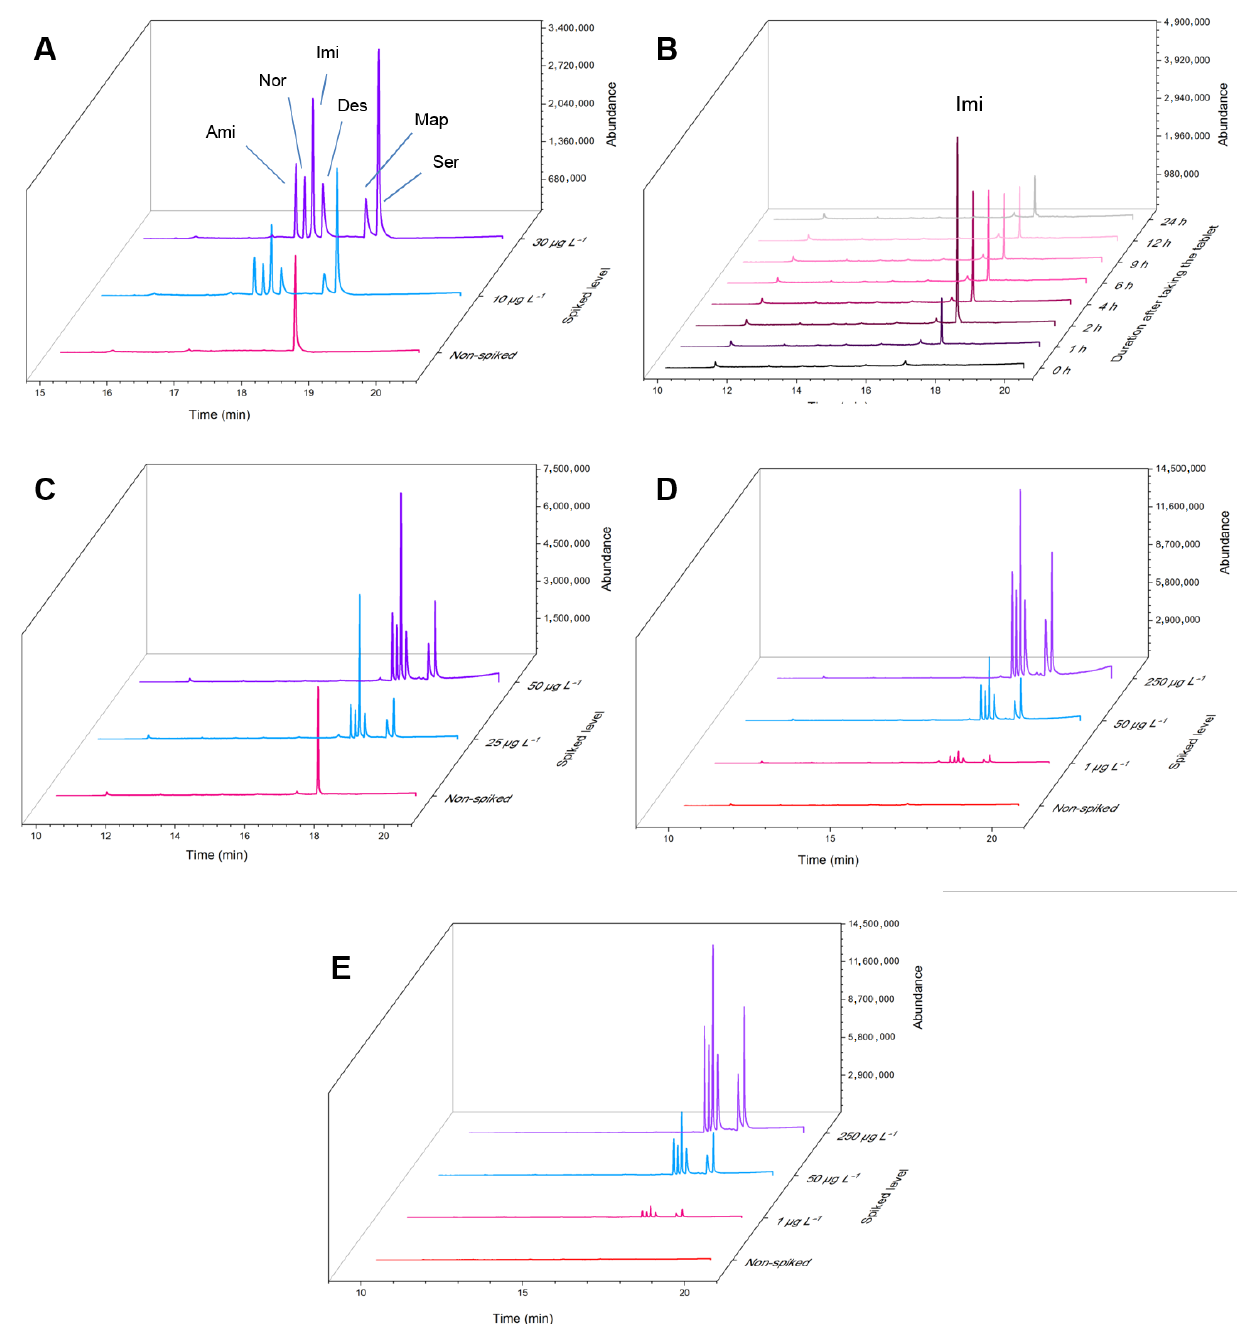
Figure 6. Obtained GC–MS chromatograms related to extraction of TCAs from ( A ) human bone marrow aspirate sample; ( B ) urine samples taken at different hours after consumption of imipramine; ( C ) urine sample taken 2 h after consumption of imipramine; ( D ) drug-free plasma sample; ( E ) well water sample, and their different spiked levels.